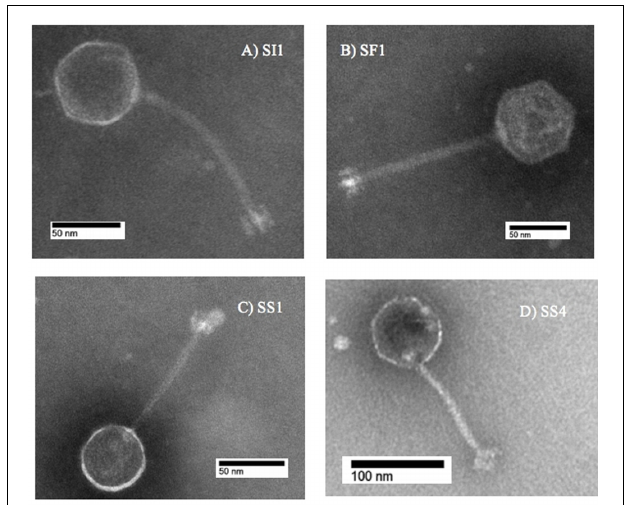
FIGURE 1 | Transmission electron microscope images of (A) SI1, (B) SF1, (C) SS1, and (D)